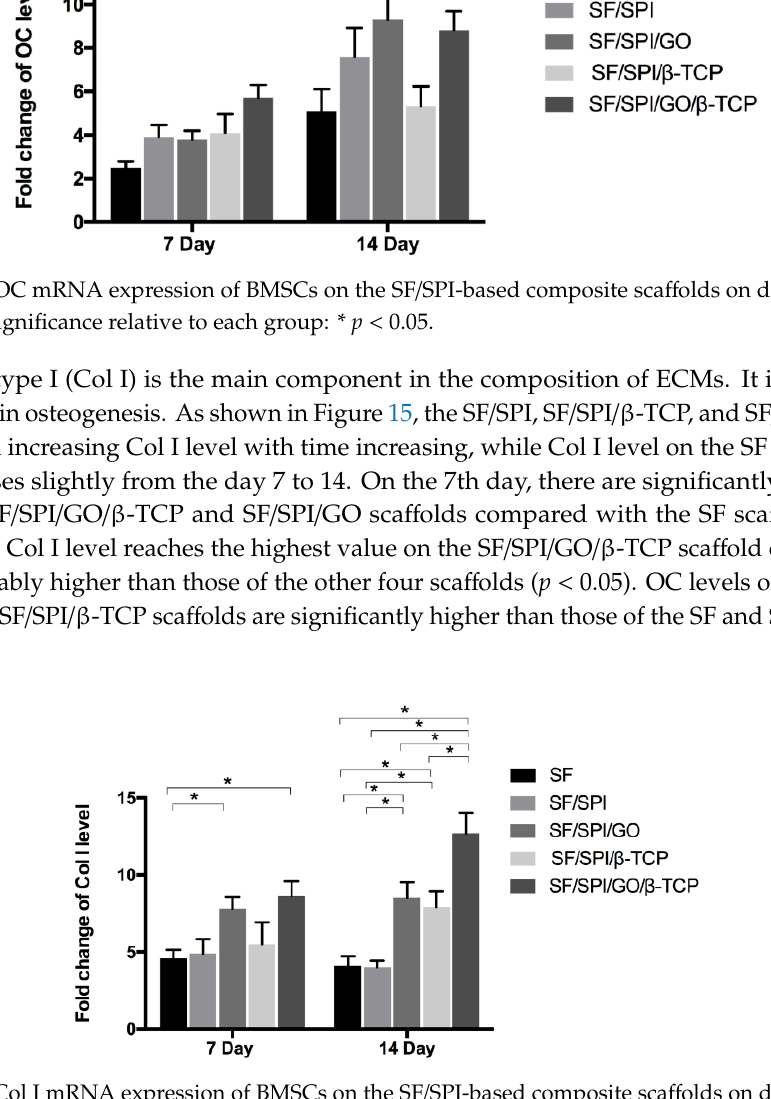
Figure 15. Col I mRNA expression of BMSCs on the SF/SPI-based composite scaffolds on day 7 and 14. Statistical significance relative to each group: * p < 0.05.